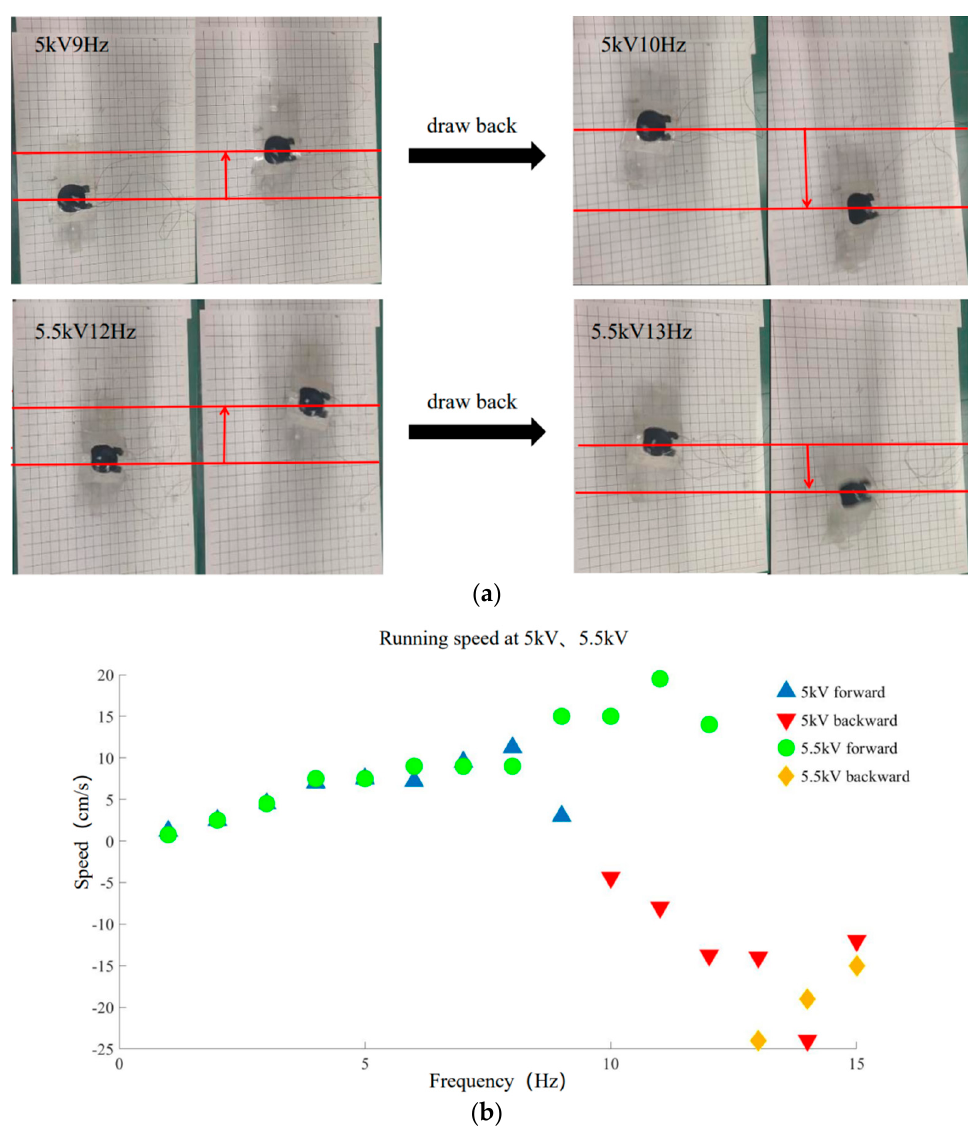
Figure 7. Backward running experiment. ( a ) Backward running experimental 5 kV and 5.5 kV. Red line positioning robot is used to indicate the running direction of robot; ( b ) Running speed of 1–15 Hz at 5 kV, 5.5